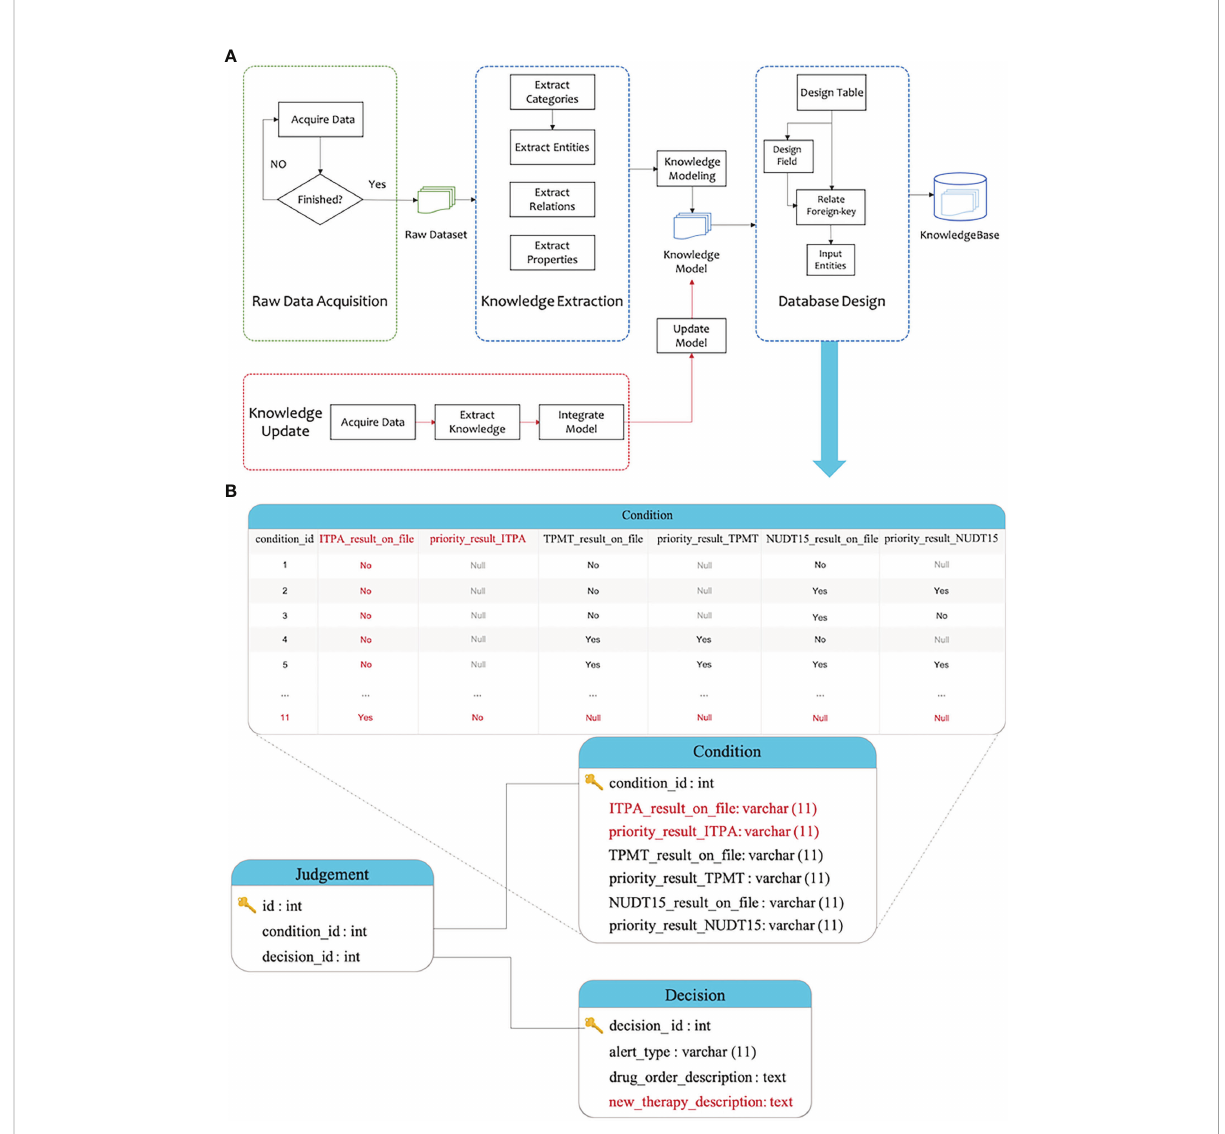
FIGURE 5 Modelling of CDS and its change with the traditional approach. (A) The traditional approach requires complex modi fi cations to accommodate a new data table. (B) The knowledge content in the traditionally modelled knowledgebase. Table records need to be modi fi ed when a new data table is to be integrated into the